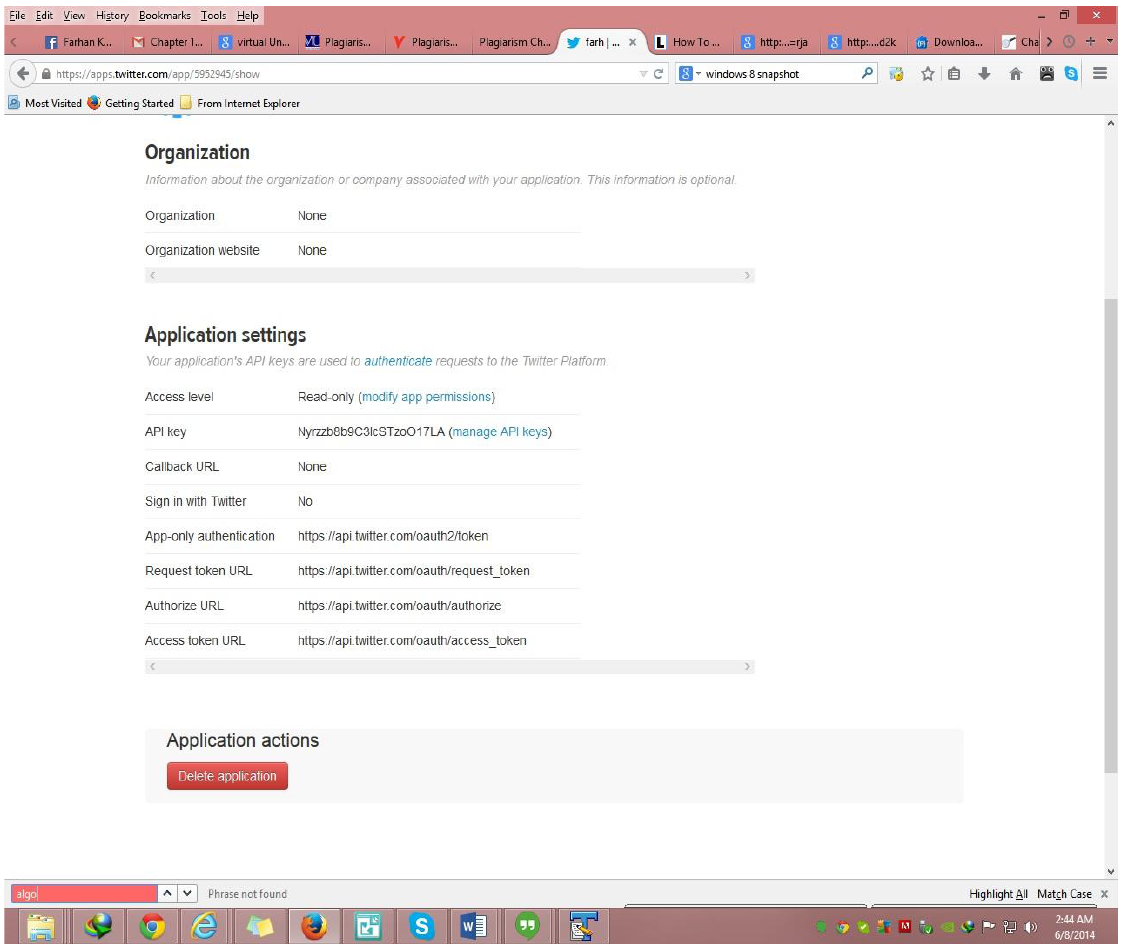
Figure 2. Twitter Oath Authentication